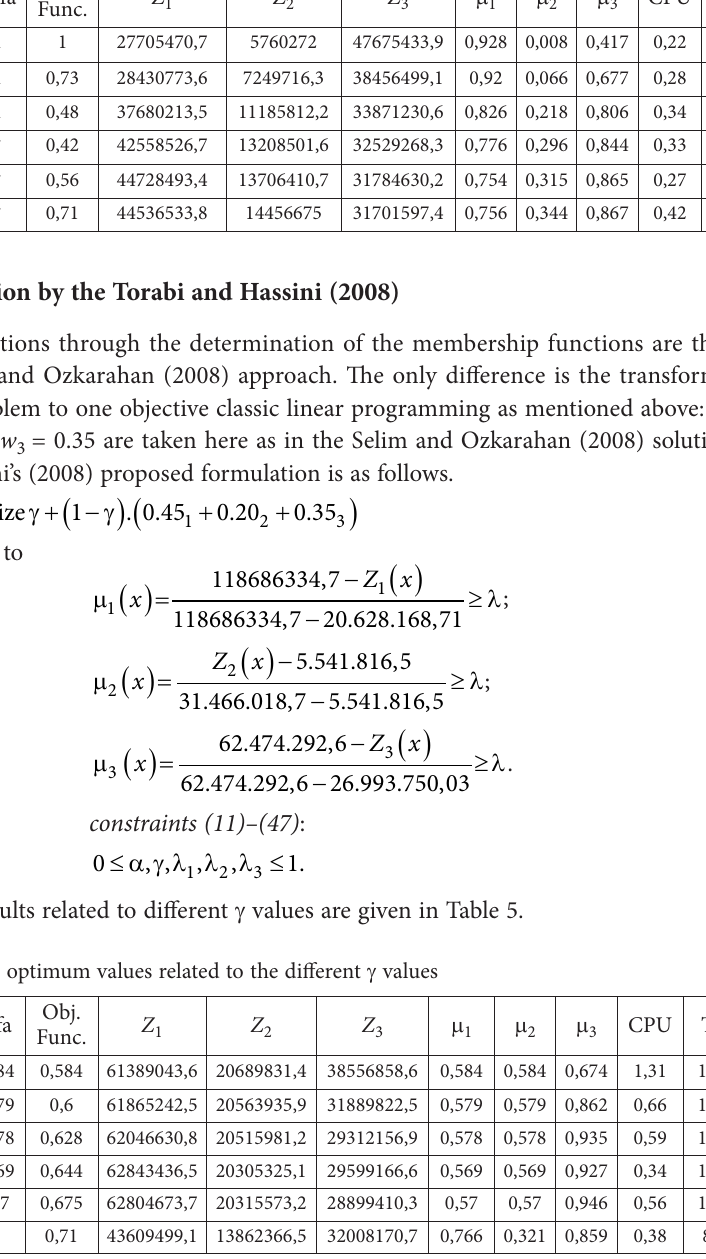
Table 4. The optimum values related to the different g values Obj. Gama Alfa Func.